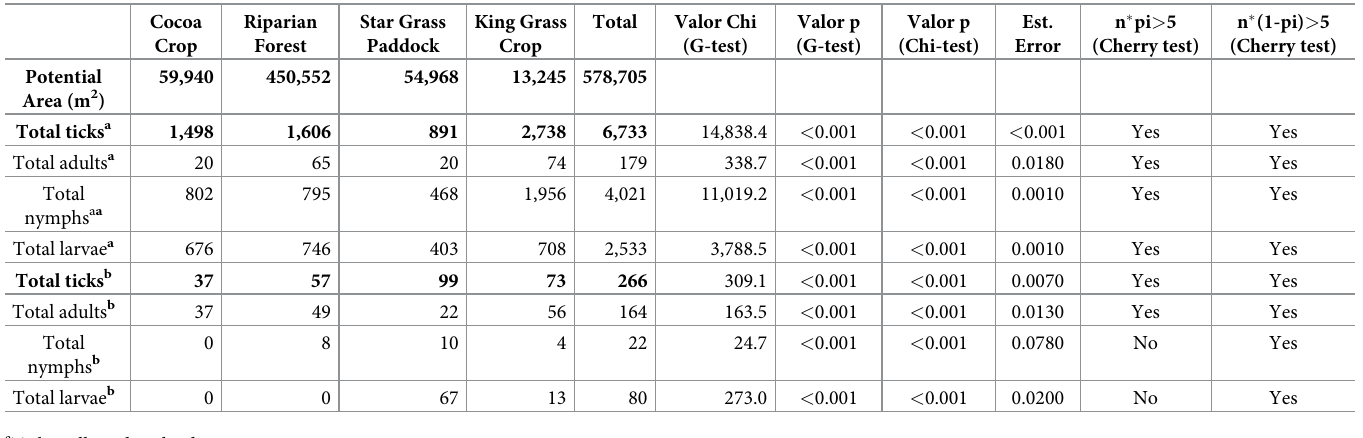
King grass crop. Solar radiation was low with an average of 70 W/m 2 and a difference of 145 W/m 2 between the extreme values recorded (cloudy day), which can be explained by the height of the King Grass (about 2 m) and the dense vegetation. In this sense, the humidity was Table 3. Calculations of potential area and A . mixtum abundance within each habitat to obtain the observed use. Cocoa Riparian Crop